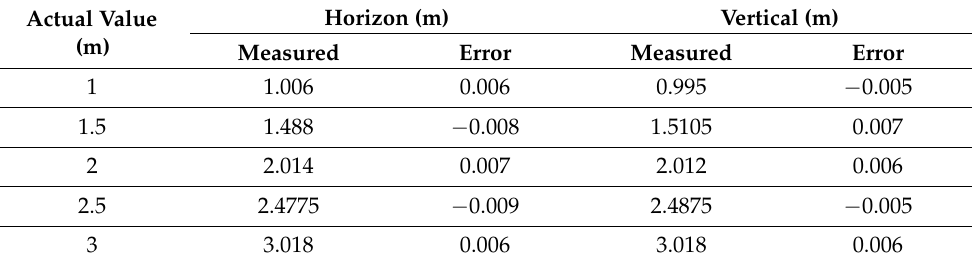
Table 4. Tag recognition performance at 150 m.